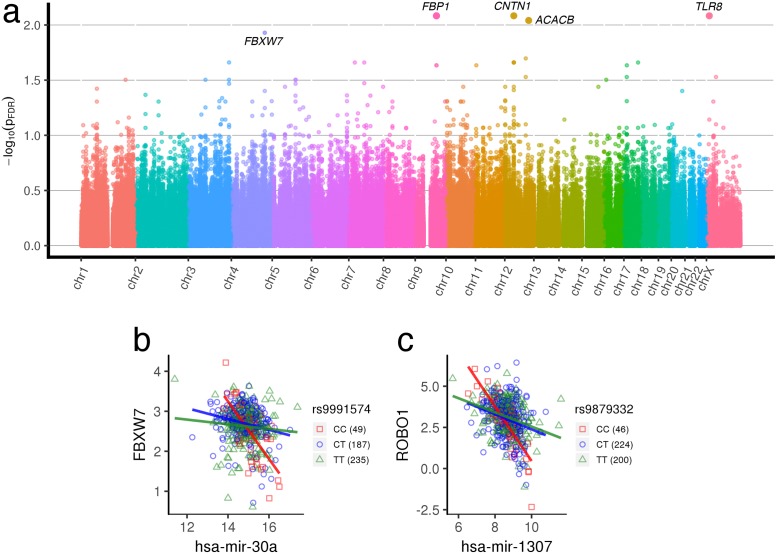
Prostate cancer regQTLs.(a) Manhattan plot of regQTL −log10
FDR values in TCGA PRAD data. (b, c) Examples of prostate cancer gene-miRNA-SNP trios with significant regulatory differences across genotypes. All trio interactions pFDR < 0.05. More trios are indicated in S1 Text.